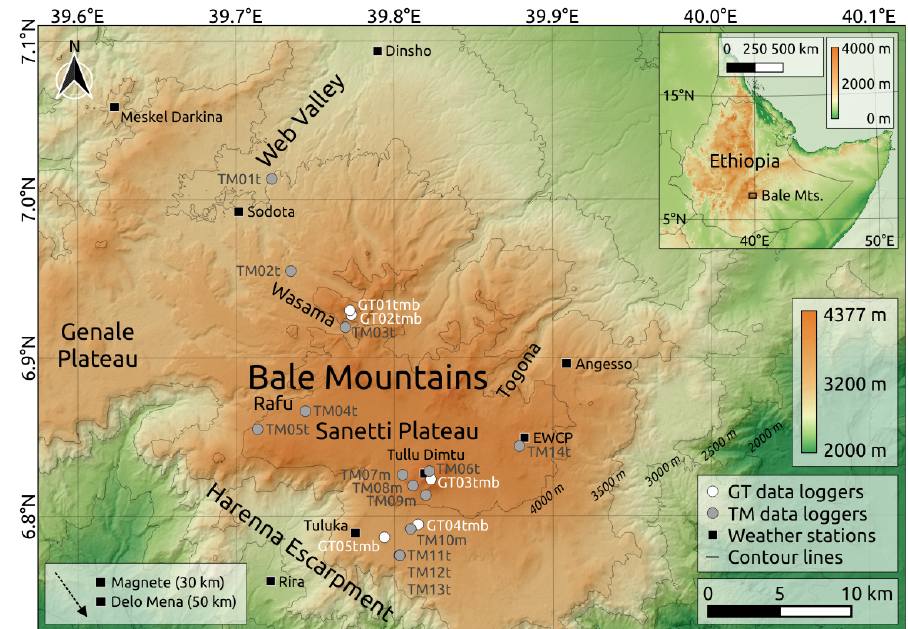
Figure 1. Overview map of the ground temperature monitoring network and automatic weather stations in the Bale Mountains (southern Ethiopian Highlands), located in the Horn of Africa. While the high-quality GEOTEST (GT) ground temperature data loggers were installed at a depth of 2, 10, and 50cm, the low-cost tempmate. ® -B2 (TM) ground temperature data loggers were only placed at a depth of either 2 or 10cm. The measurement depth of all loggers at each site is indicated by the lower-case letters t (top, 2cm), m (middle, 10cm), and b (bottom, 50cm). All low-cost TM data loggers were collected in January 2020. The measurements are being continued at all five GT sites (white dots). The two weather stations, Magnete and Delo Mena, are located outside the map area. Data basis: SRTM 1 Arc-Second Global (United States Geological